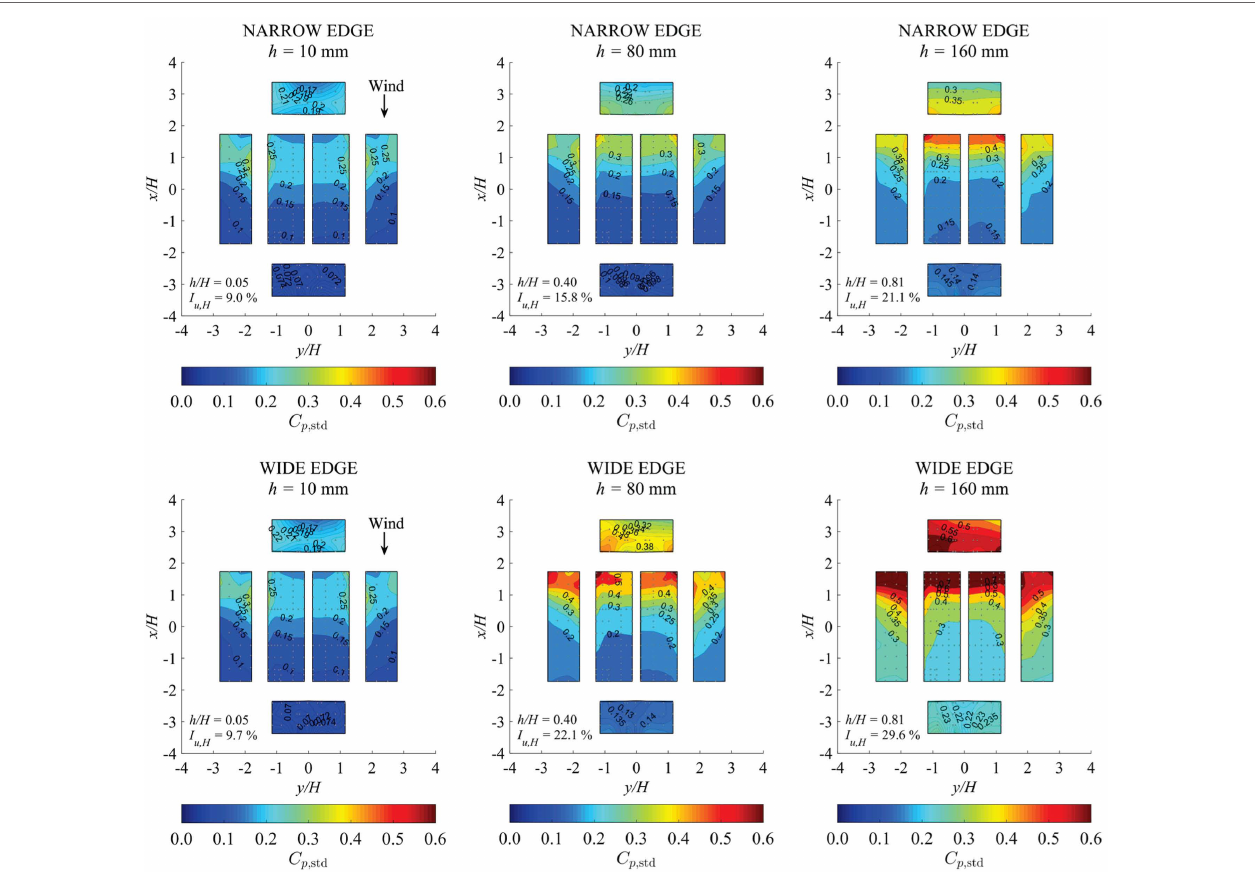
FIGURE 8 | Contours of the pressure coefficient SD referenced to the mean velocity pressure at the eave height of the 1:20 model of the Wind Engineering Research Field Laboratory Building.